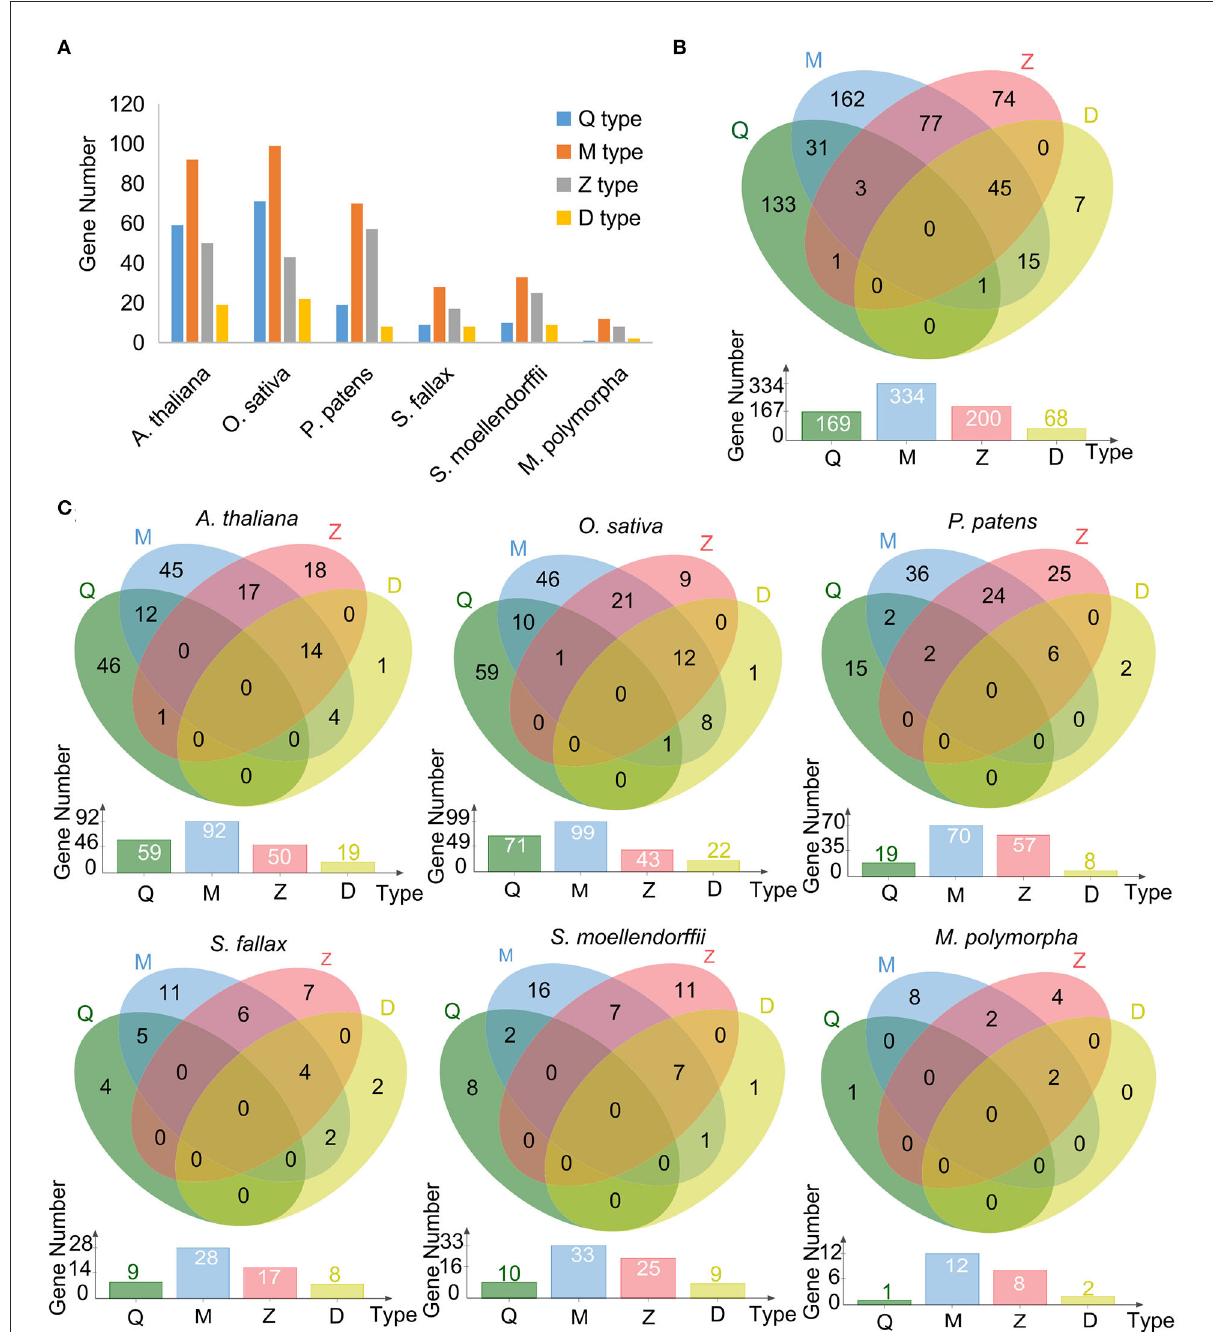
FIGURE2 Subset classification of C2H2-ZFPs in the representatives of land plant lineages. (A) Bar diagram summarizes the distribution of each type of C2H2-ZF domains in six representative land plant species. (B) Venn diagram summarizes the distribution of each type of C2H2 domains in six representative land plant species. (C) The detailed distribution of each C2H2-ZF domain in each representative.